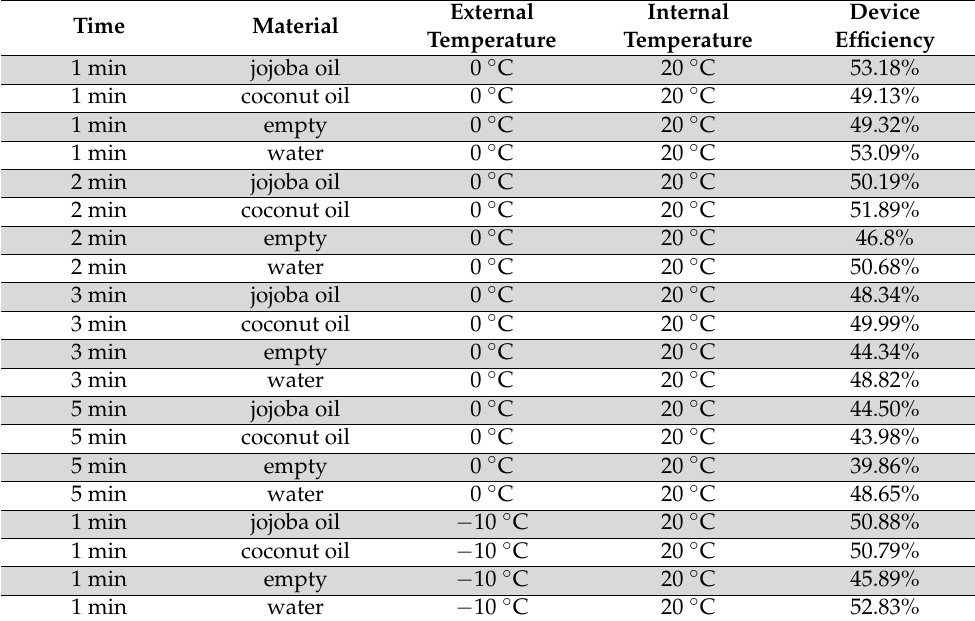
Table 7. Unit efficiency with heat exchanger